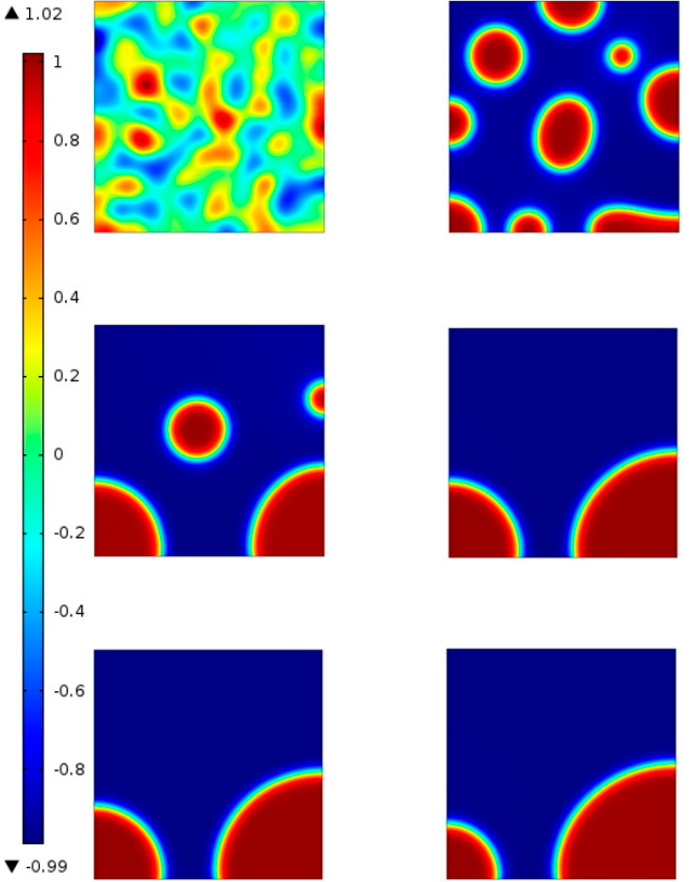
Figure 10. Phase distribution at different time instants under cooling loading.